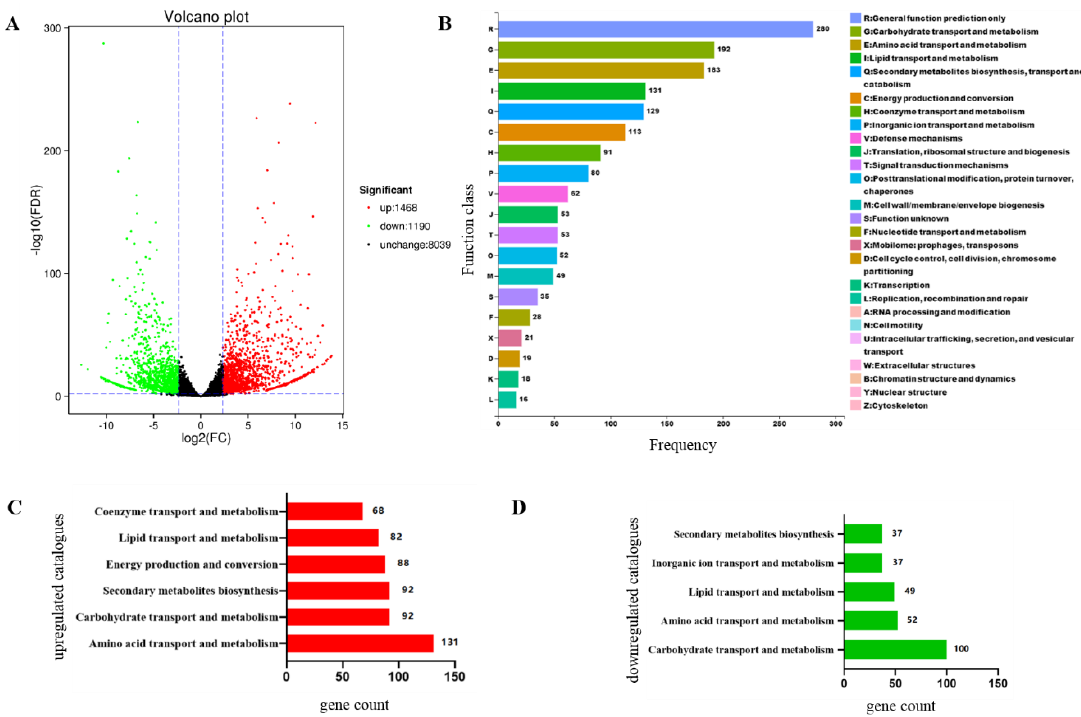
Figure 5. Transcriptomic analysis of the WT and ∆ Focpmi1 mutant. ( A ) Volcano plots displaying the differential gene expression between WT and the mutant. ( B ) COG functional annotation showing the distribution of differentially expressed genes between the two strains. ( C ) Pathway analysis of up-regulated genes and ( D ) pathway analysis of down-regulated genes, revealing the most influenced and disturbed pathways.